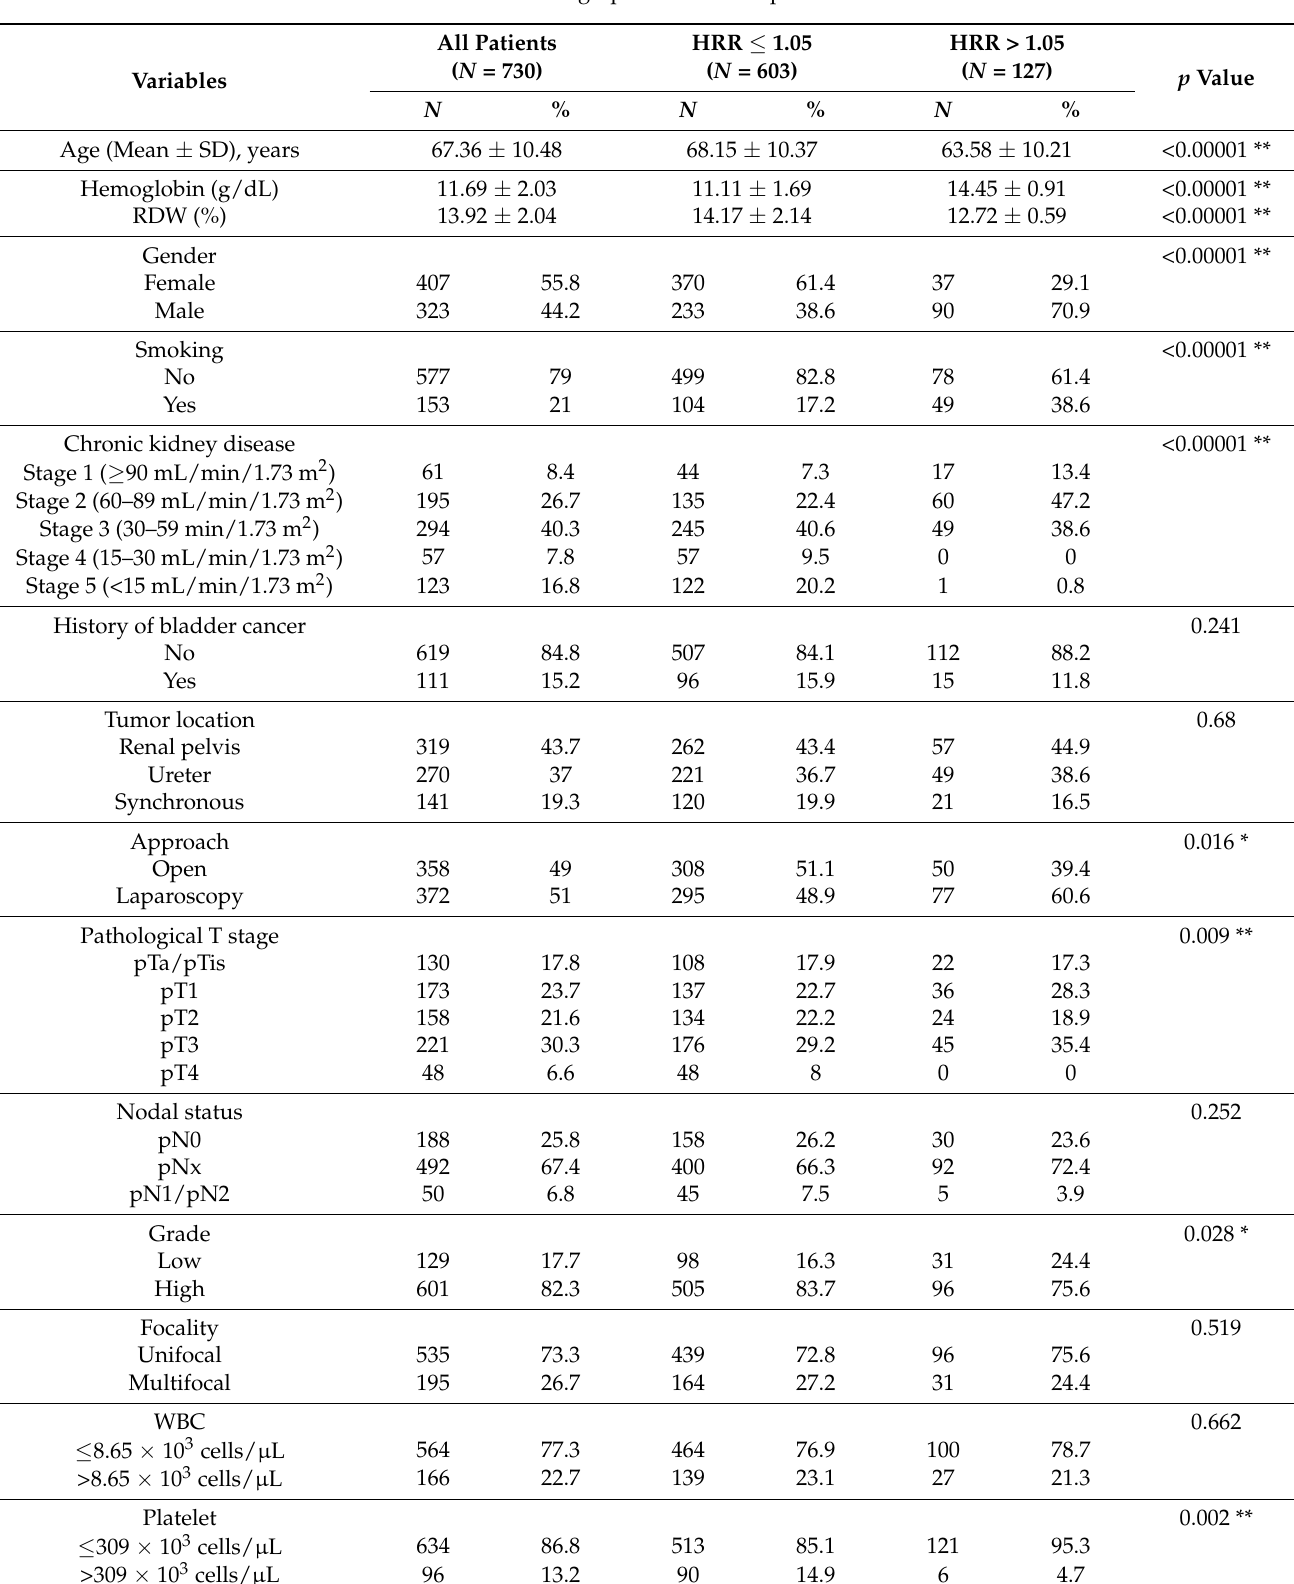
Table 1. Demographic data of the